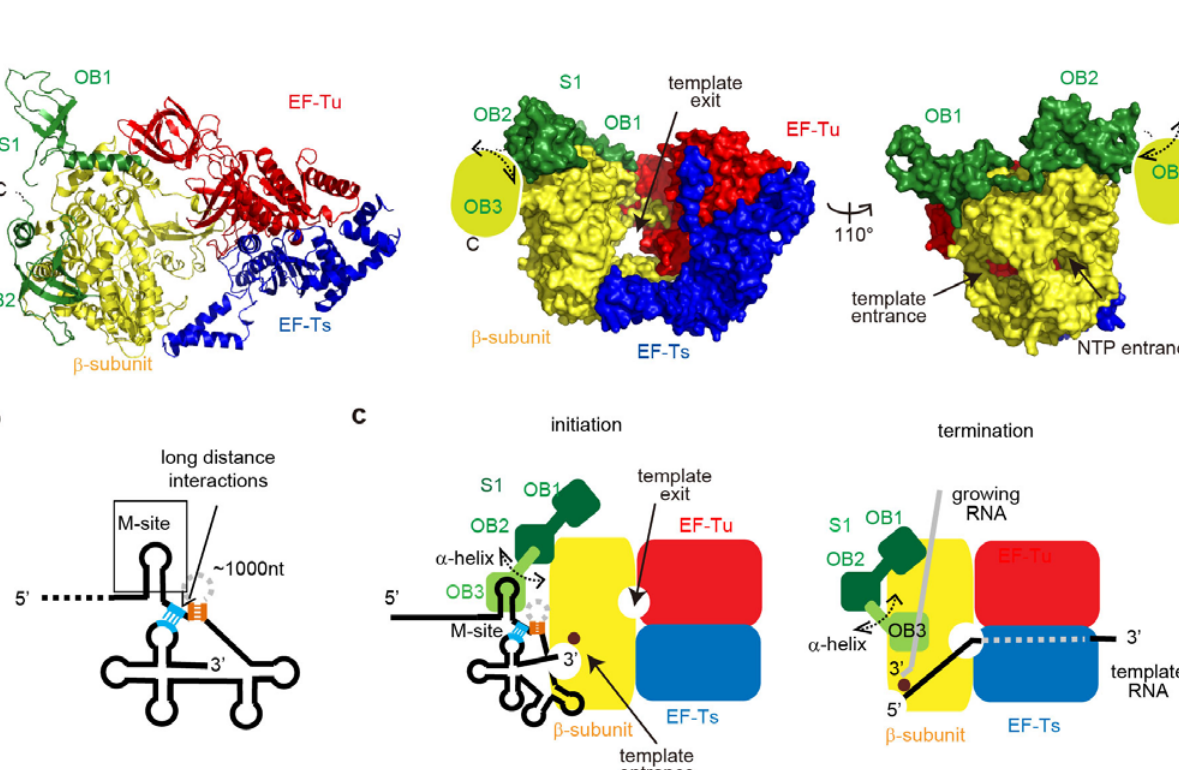
Figure 7. Structure of Qβ replicase containing the N -terminal half of S1. ( a ) Overall structure of Qβ replicase containing the N -terminal half (oligonucleotide/oligosaccharide- binding (OB)-folds OB1–OB3) of S1. The β-subunit, EF-Tu, EF-Ts, and OB1-2 are colored yellow, red, blue, and green, respectively. OB3 is mobile, and its model could not be built in the structure; ( b ) Schematic two-dimensional view of the 3'-half of Qβ RNA. The long-distance interactions in the RNA are depicted by dotted lines, and the regions used for interactions in the Qβ RNA are colored orange and sky blue; ( c ) Simplified schematic depictions of Qβ RNA replication initiation ( left ) and termination ( right ). The OB3 domain is mobile and capable of pivotal rotation, using the α helix connecting OB2 and OB3 as a swing